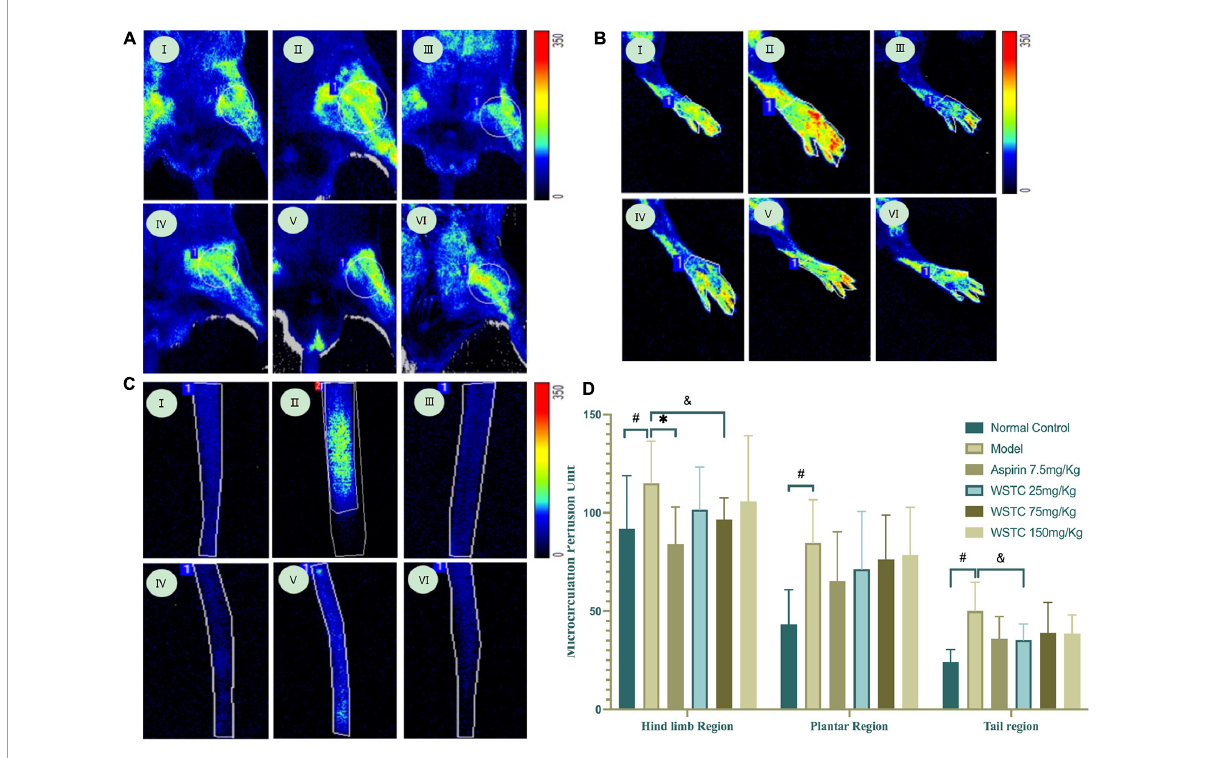
FIGURE6 Effects of water-soluble tomato concentrate (WSTC) on microcirculation perfusion and blood flow in rats with tail thrombosis. (A) Representative images showing microcirculation perfusion in the hind limb region in control group (I); model group (II); Aspirin group (III);